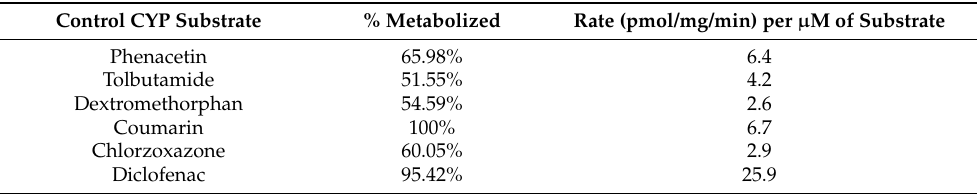
Table 3. Extent and rate of metabolism for the control CYP substrates.